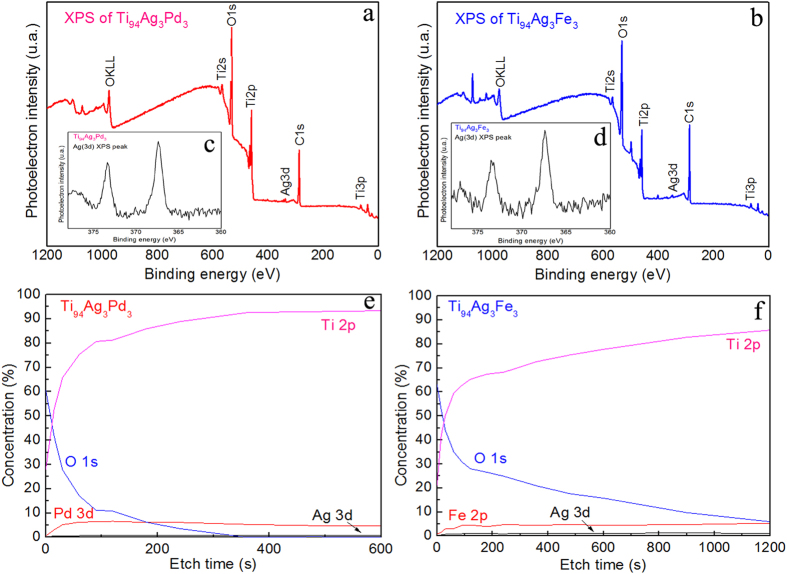
XPS spectra of Ti94Ag3Pd3 (a) and Ti94Ag3Fe3 (b); narrow-scan spectra of the Ag (3d) XPS peak for Ti94Ag3Pd3 (c) and Ti94Ag3Fe3 (d); depth-dependent elemental distributions for Ti94Ag3Pd3 (e) and Ti94Ag3Fe3 (f) as a function of etch time.